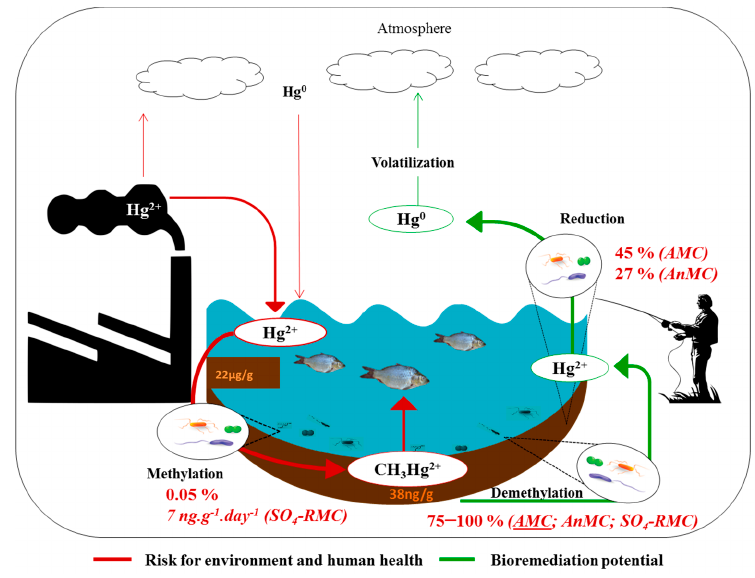
Figure 6. Summary of the results showing microbial-mediated transformations of mercury in the Tagus estuary and their context in human and environmental health. Rate conversions are the averaged values of results reported in this paper for Barreiro and Cala do Norte, and mercury concentrations in sediments, previously reported by Figueiredo et al. [7] were also averaged to indicate the sediments’